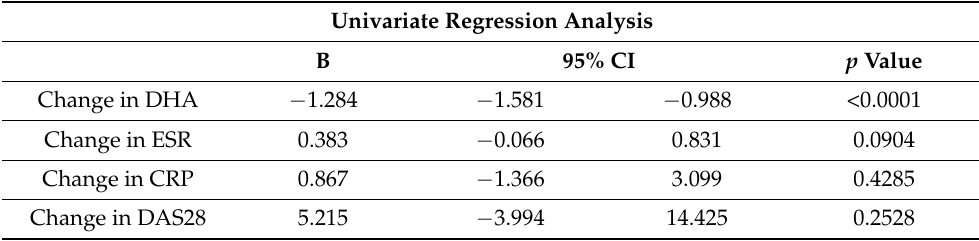
Table 2. Linear regression analysis for pain decrement after JAKi